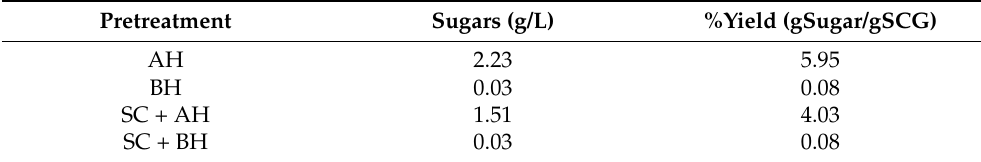
Table 2. Monomeric sugar concentration and extraction yield for each pretreatment.